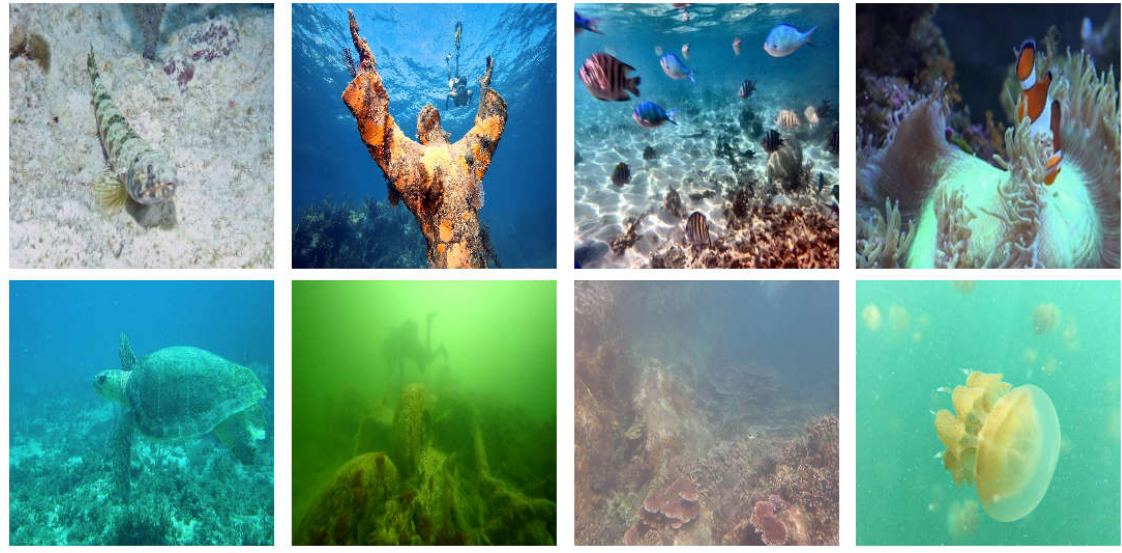
Figure 5. Samples from the training dataset. First row: underwater clear images. Second row: underwater turbid images.